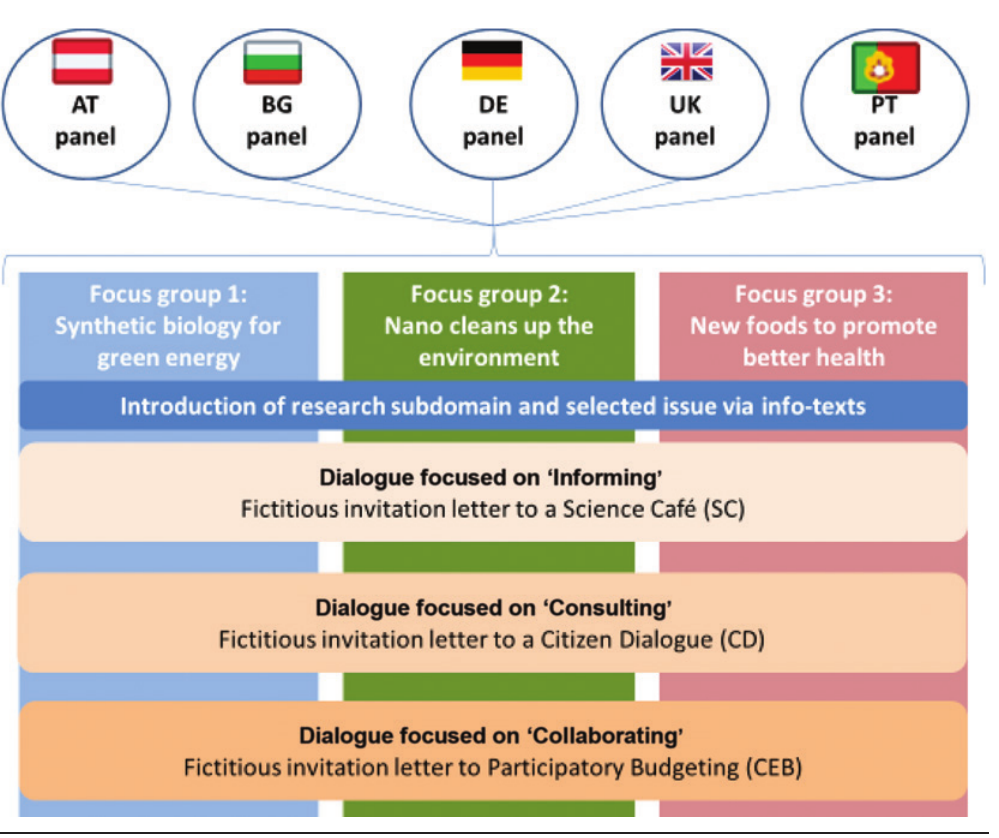
figure 1: Discussing different dialogue formats in relation to different research topics – the focus group design (based on chonkova et al., 2017: 8, with small